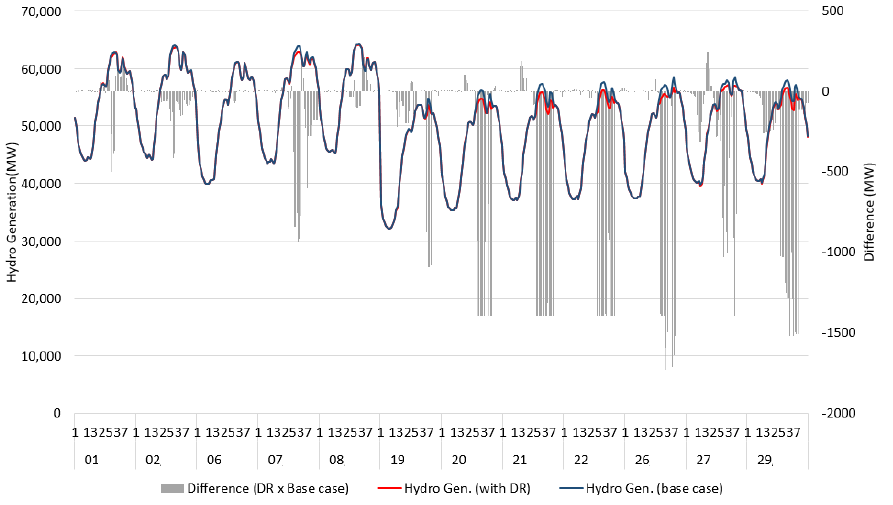
Figure 10. Total system hydro generation.